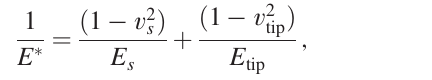
TABLE I. Geometrical characteristics of the cantilever, exper- imental values of the free resonance frequency, and contact resonance frequencies for a and c domains of bulk BaTiO 3 and the corresponding wavelengths as calculated by Eqs. (1) and (2). The experimental value of the cantilever ’ s spring constant ( k and the calculated normalized contact stiffness k (cid:2) =k